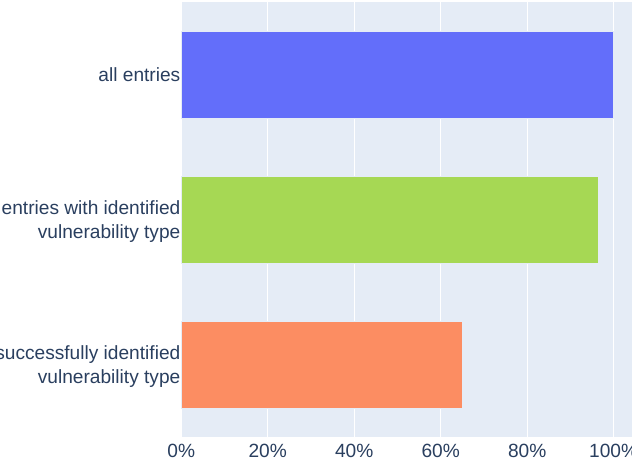
Figure 9. Comparing extracted vulnerability types with vulnerability type information from the test dataset.